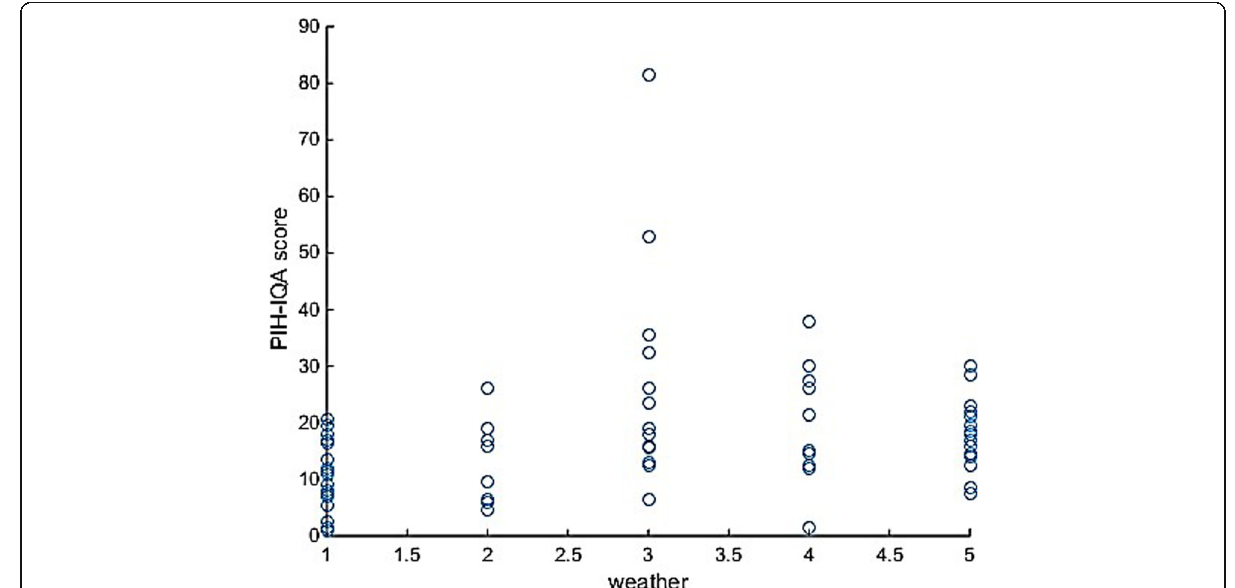
Fig. 7 The scatter of the relation between aerial images and weathers of the PIH-IQA method